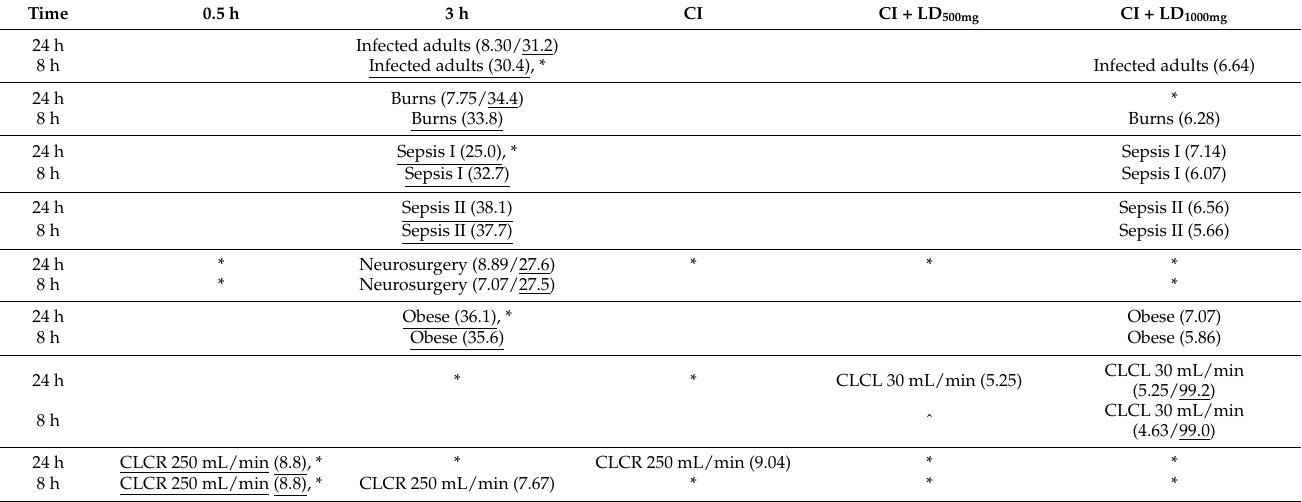
Table 3. Most favourable dosing regimens (total daily dose ≥ 6000 mg) with respect to total bacterial load and f T >MIC at 8 h and 24 h based on plasma PKPD profiles (covering 95% of patients) for the investigated